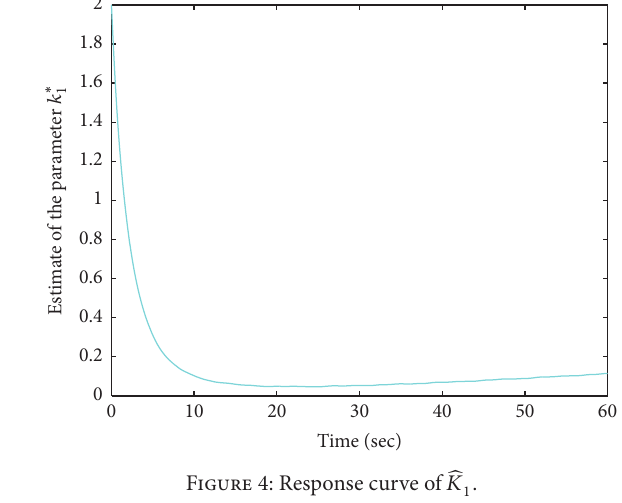
Figure 4: Response curve of